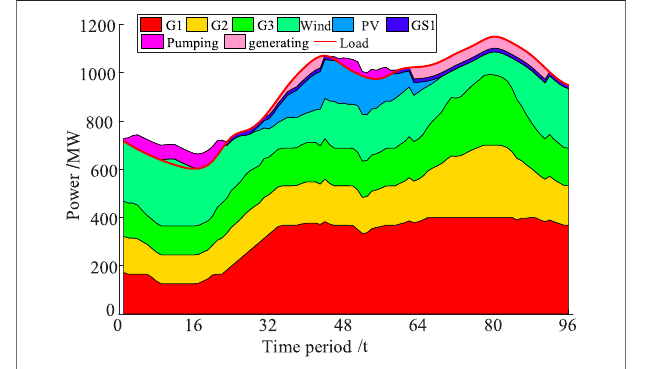
FIGURE 7 | Unit output curves of Case 2.